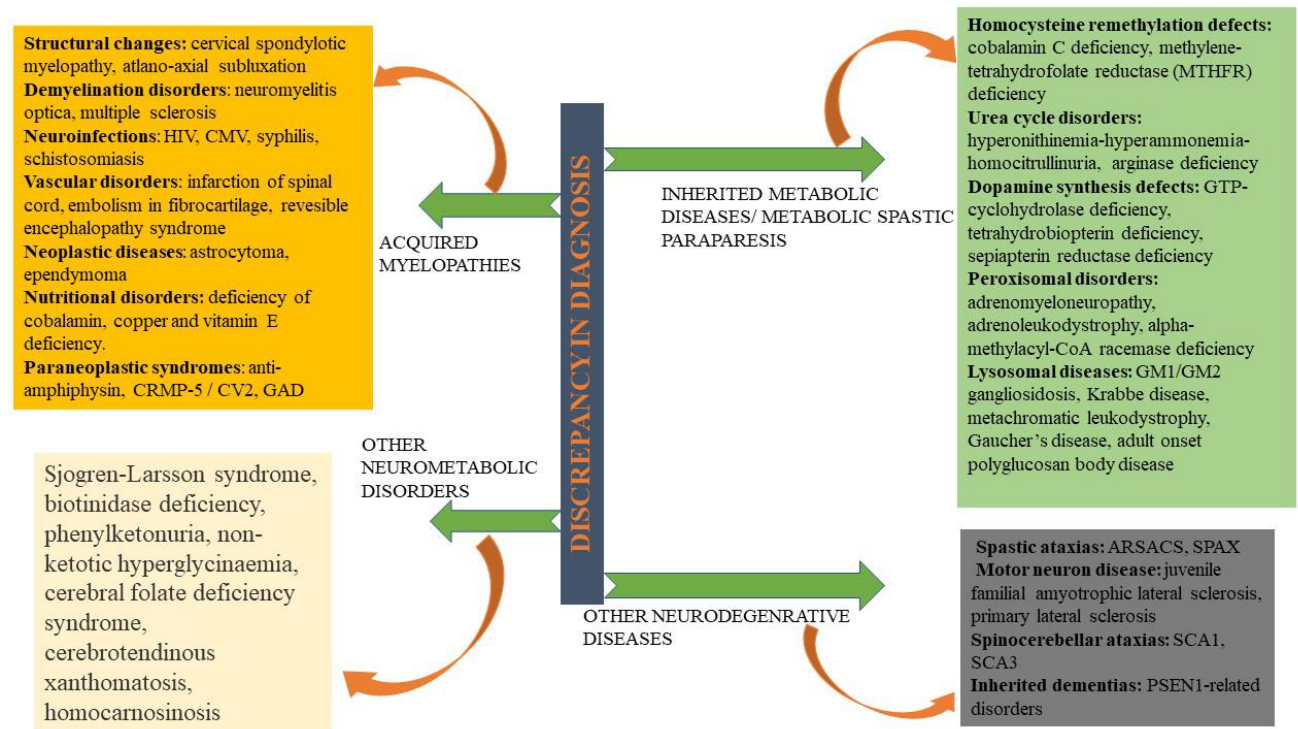
Figure 3. Differential diagnosis of HSP—Being an extremely heterogeneous disorder in clinical and genetic aspects, HSP is often misinterpreted with acquired myelopathies, neurometabolic disorders, inherited metabolic paraparesis, and some neurodegenerative disorders. ARSACS: Autosomal recessive spastic ataxia of Charlevoix – Saguenay; SCAs: Spinocerebellar ataxias; CMV: Cytomegalovirus; CRMP-5: Collapsin response mediator protein-5; GAD: Glutamate decarboxylase; HTLV: Human T lymphotropic virus; HIV: Human immunodeficiency virus; PSEN: Presenilin; SPAX: Spastic ataxia.